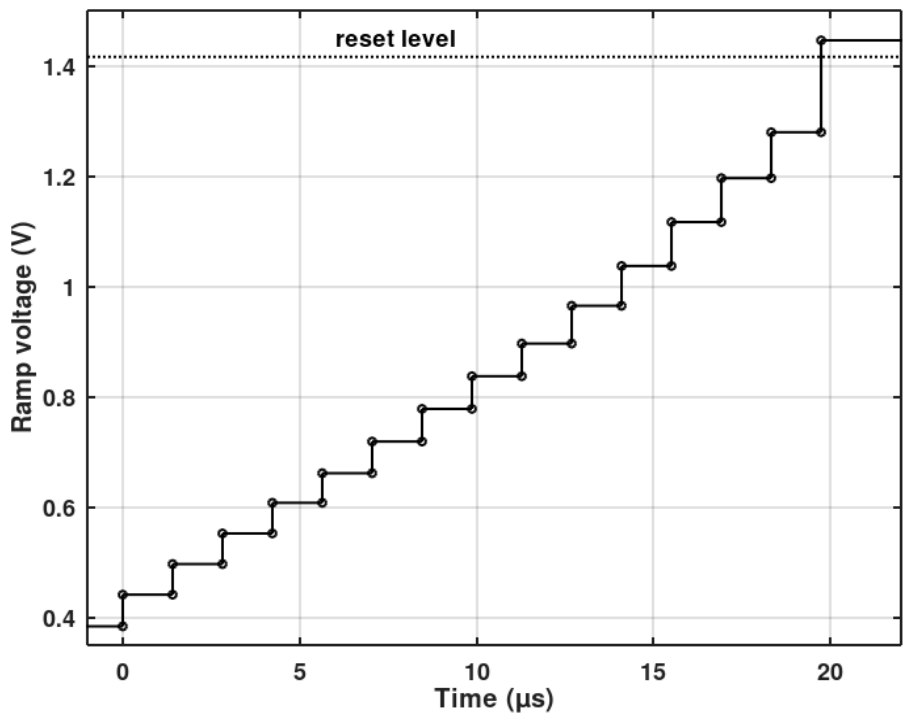
Figure 15. Ramp signal after linearity optimization of the voltage-mode phase 1b of the proposed pixel-ADC. The last ramp step ensures that all pixel counters are turned on before the start of the offset correction phase.